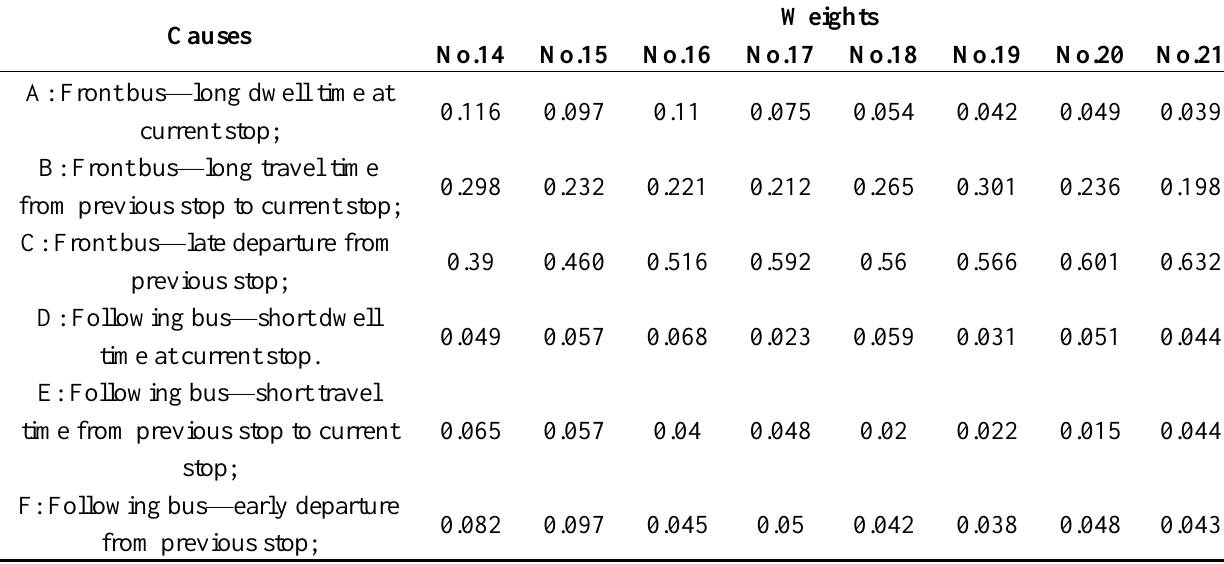
Table 10. The results of causes weight